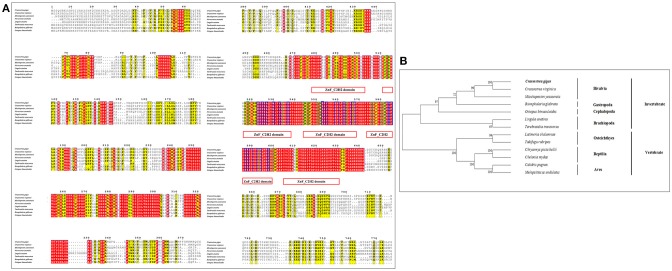
(A) Multiple sequence alignment of the CgGli amino acid sequence among species. The conserved functional structure are marked in box. Identical residues are shown as white letters with red background, and similar residues are shown as black letters with yellow background. (B) Neighbor-joining phylogenetic tree based on the amino acid sequences of the CgGli.